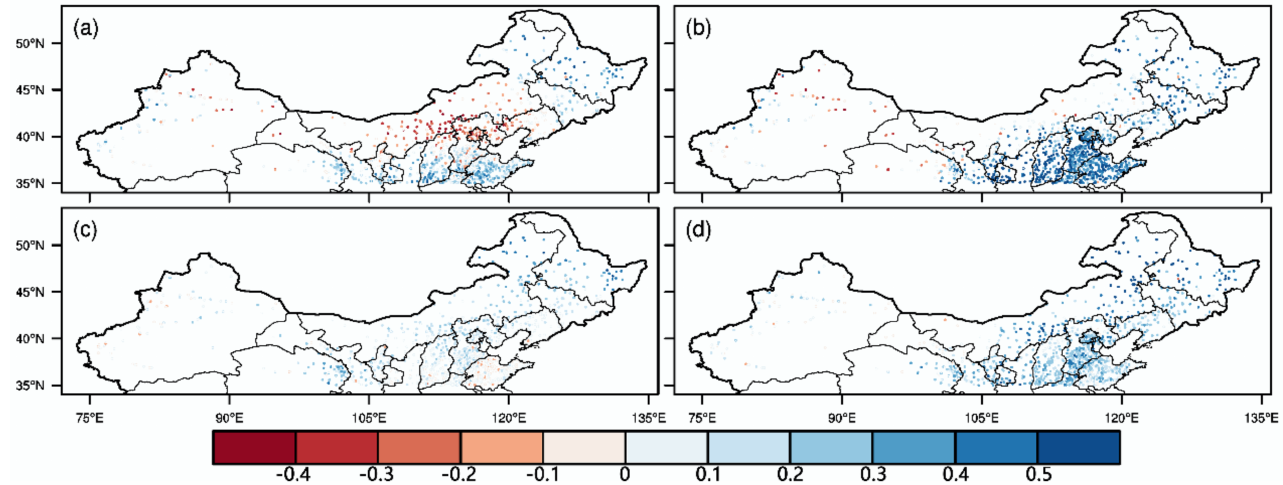
Figure 4. Spatial distribution of correlation coefficients between in situ and products derived from ( a ) AMSR2, ( b ) CCI, ( c ) SMAP, and ( d ) SMOS. Closed circles are statistically significant at the 99% confidence level, while the open ones are